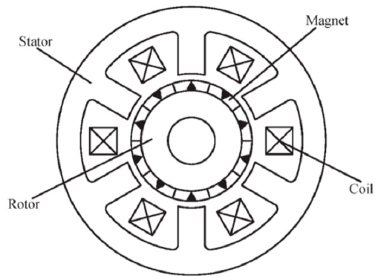
World Electr. Veh. J. 2021 , 12 , x FOR PEER REVIEW Figure 4. Configuration of a surface Vernier PM (SVPM) machine [18]. Figure 4. Configuration of a surface Vernier PM (SVPM) machine [18].